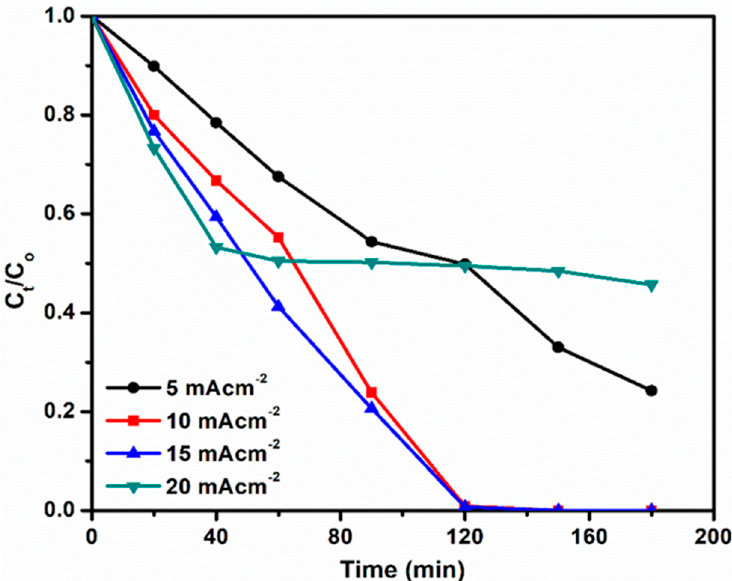
Figure 6. Effect of current densities on the PEC degradation of paracetamol on FTO-BiVO 4 /BiOI (pH 3; 0.1 mM paracetamol). Reproduced with permission [52]. Table 2. PEC acetaminophen degradation using BiVO 4 -based photoelectrodes.